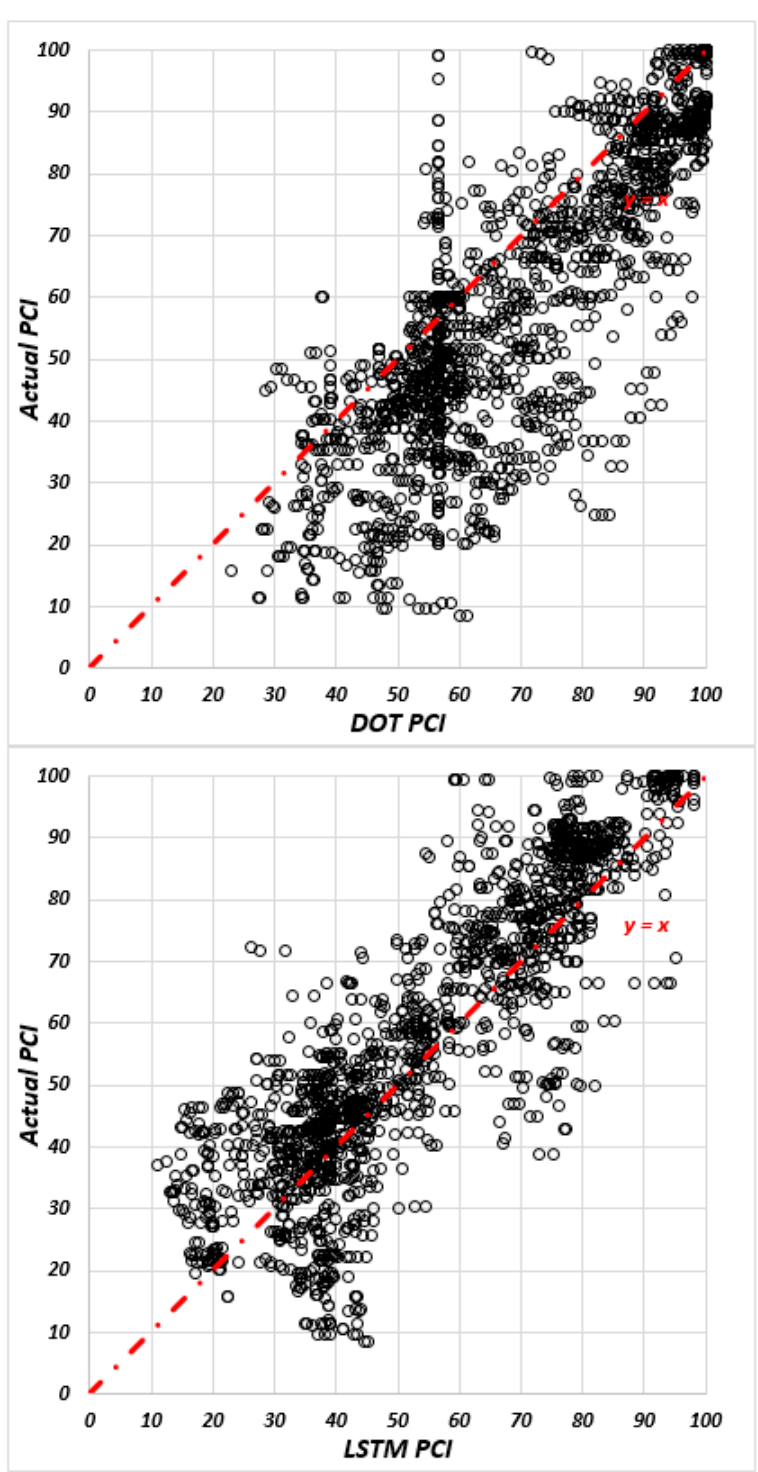
Figure 5. The actual PCI over predicted PCI in COM sections for DOT and LSTM models, respectively.